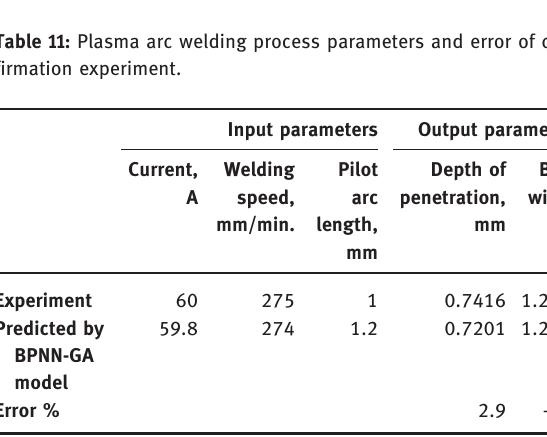
Figure 7: Genetic algorithm convergence plot.